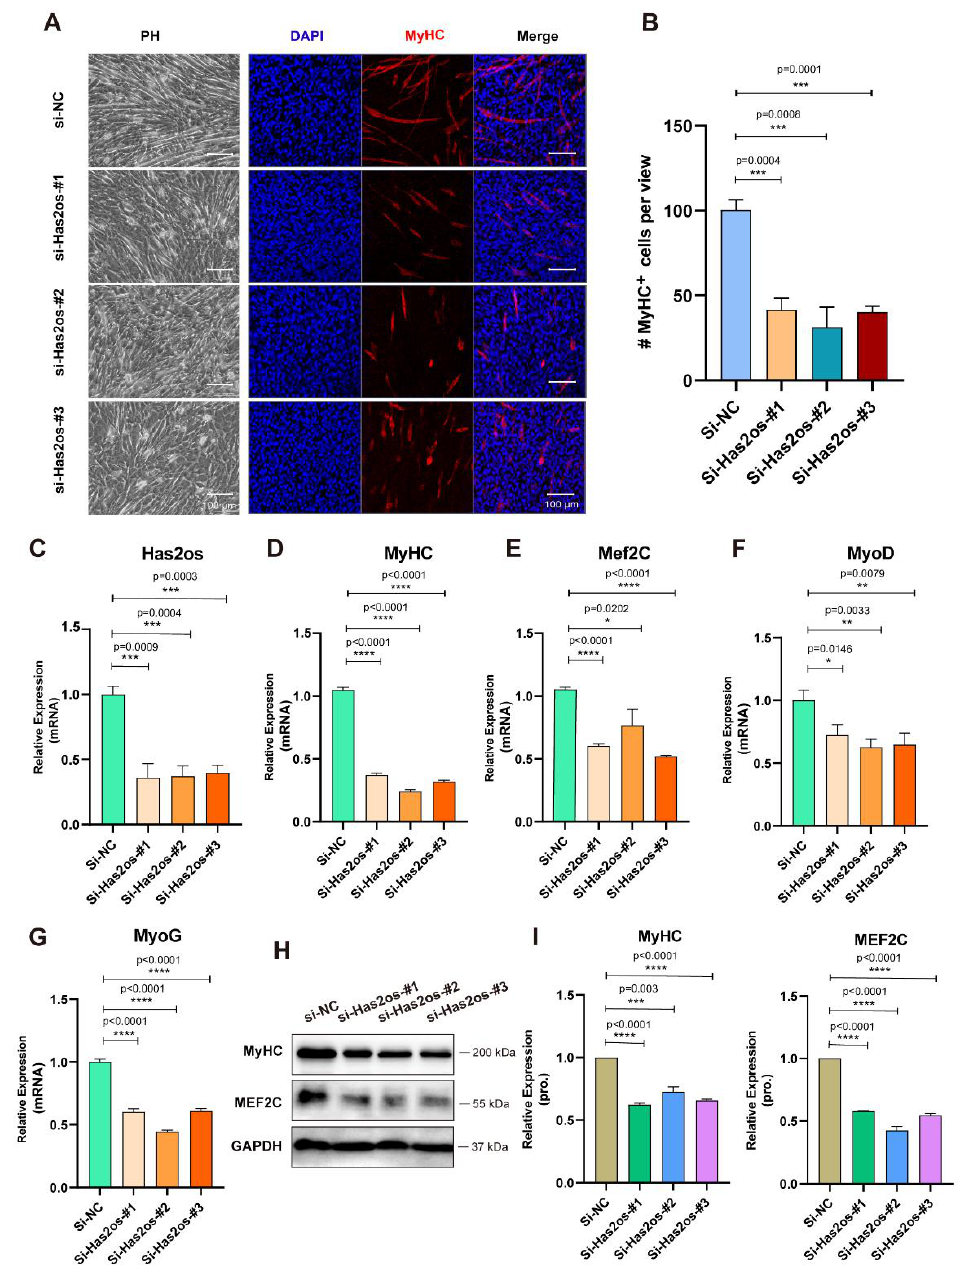
Figure 3. Has2os knockdown inhibited myoblast differentiation. ( A ). Inhibition of myocyte fusion upon Has2os knockdown. Transfected cells were maintained in growth medium for two days and shifted into DM for differentiating another three days, then cells were photographed by microscope to show the morphological changes. Immunofluorescence microscopy analyzed the expression of myogenesis marker MyHC as red fluorescence in C2C12 cells transfected with si-Has2os or si-NC. Scale bar = 100μm. ( B ). MyHC+ cells were calculated based on staining described in panel A . The results are normalized to those of with si-NC. ( C ). The qPCR results showed a successful Has2os knockdown by si-RNA. ( D – G ). The qPCR results showed the downregulation of the differentiation marker MyHC, Mef2C, MyoD, and MoyG after Has2os knockdown. ( H ). The Western blot results showed the downregulated myogenesis marker MyHC and MEF2C after Has2os knockdown. ( I ). Relative expression in H were calculated. GAPDH was the internal control. Values were presented as means ± SEM. The statistical significance was calculated by t -test.